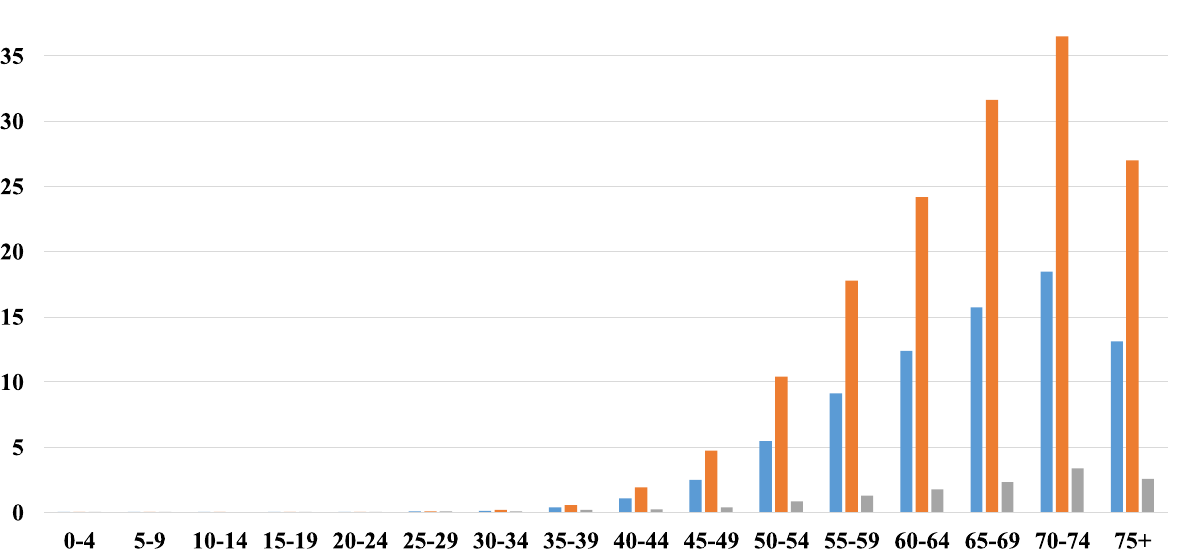
Fig. 1 Laryngeal cancer incidence with age from 2001 to 2019 (per 100,000 population) in Sri Lanka